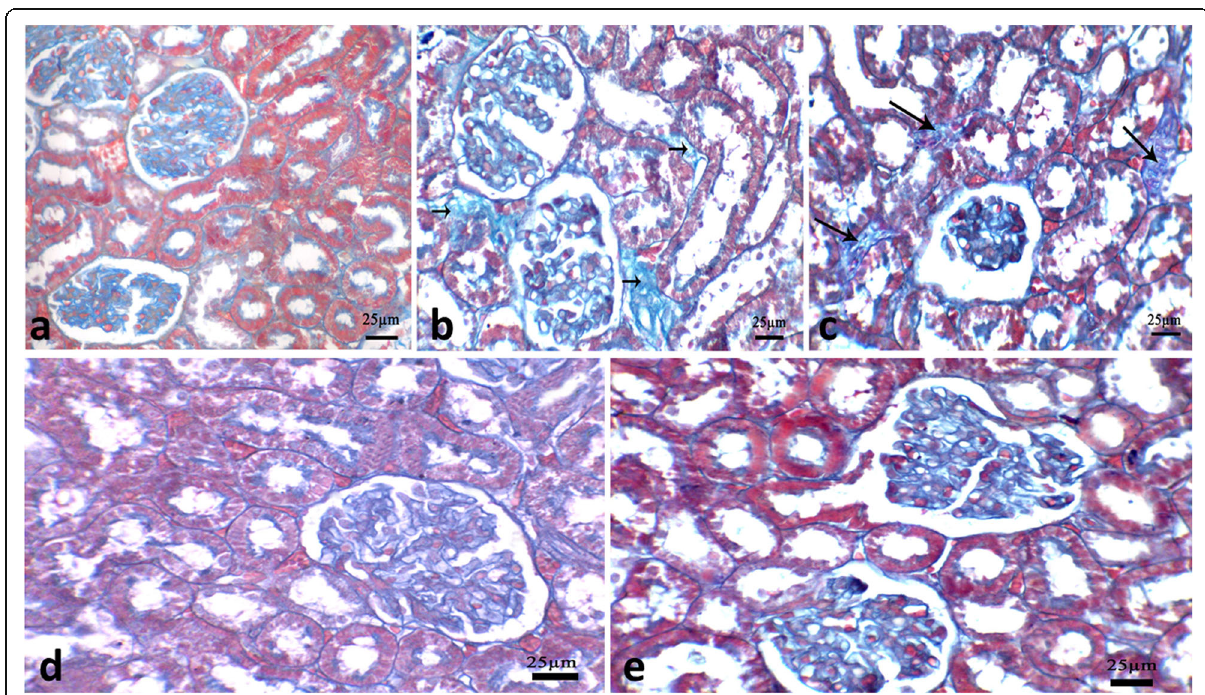
Fig. 4 Mallory trichrome stained renal cortex sections at magnification × 400, bar 25 μ m. a Control group shows thin blue collagen fibers around renal glomeruli and tubules. b Diabetic nephropathy (DN) group shows excess blue stained collagen fibers around tubules and around and within the glomeruli, and there are foci of interstitial fibrosis (arrow). c Fibroblast group shows excess collagen fibers within the glomeruli, and around tubules also foci of interstitial fibrosis (arrow) are noted. d AD-MSCs group with minimal collagen fibers around glomeruli and tubules. e Culture medium (CM) group shows minimal collagen fibers around glomeruli and